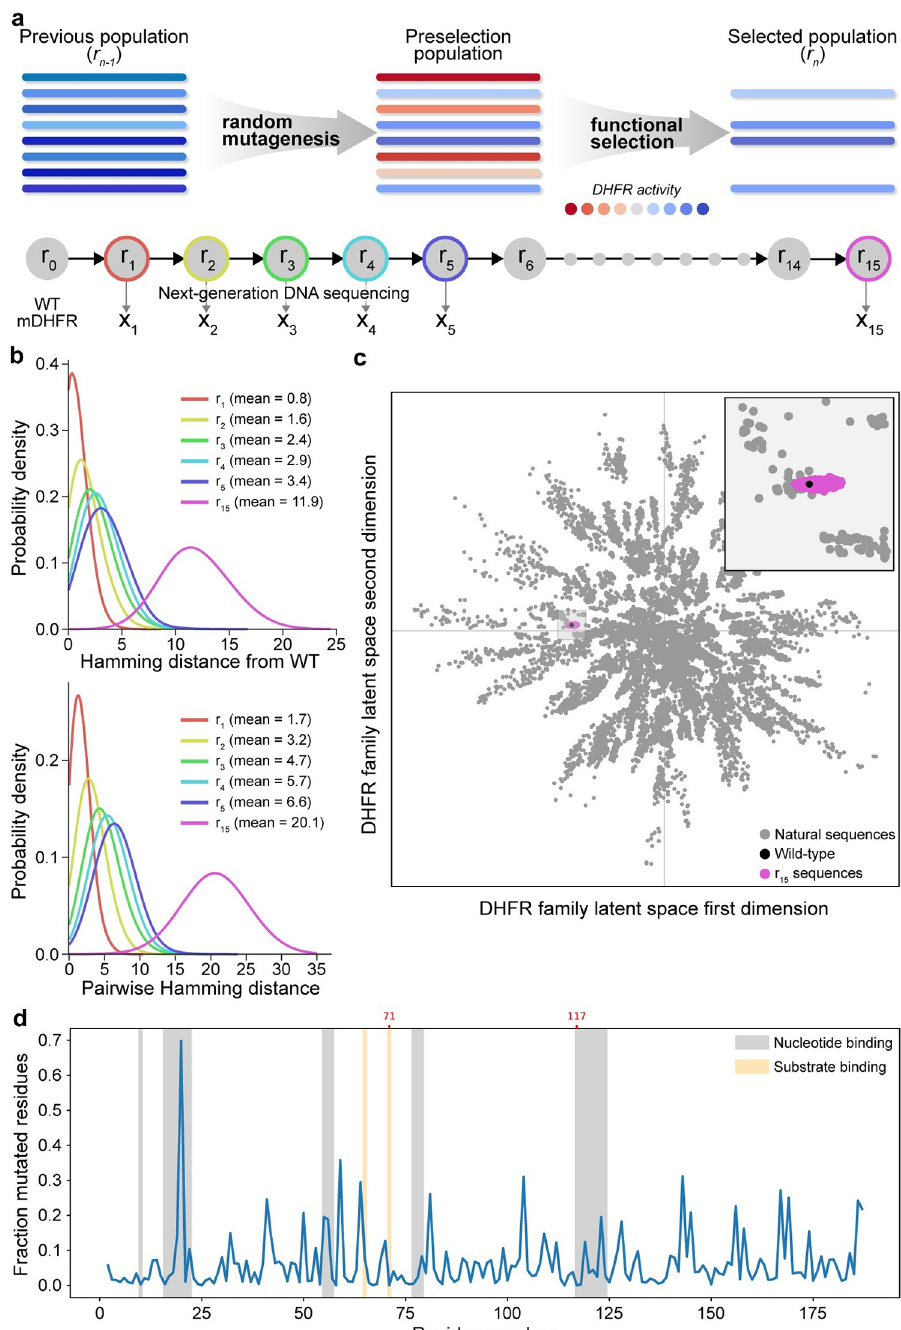
Fig 1. Experimental DHFR laboratory evolution (a) Laboratory evolution combines iterative rounds of random mutagenesis and functional selection to evolve populations of molecules. We performed 15 rounds of evolution on DHFR and sequenced the population at generations 1–5 and 15 to obtain snapshots along the evolution trajectory. (b) Sequence statistics of the experimental evolving populations displayed increasing distance from wild-type DHFR and increasing distance between sequences within a population, suggesting a diffusion-like spread into protein sequence space. (c) Visualization of the round 15 population in the context of natural DHFR sequences. The laboratory evolution experiment explored a small fraction of DHFR sequence space. Sequences were visualized using a two dimensional latent space of a variational auto encoder (VAE) trained on natural DHFR sequences (Details of the VAE are available in S2 Text). (d) The mutational statistics of sequences from the round 15 population displayed